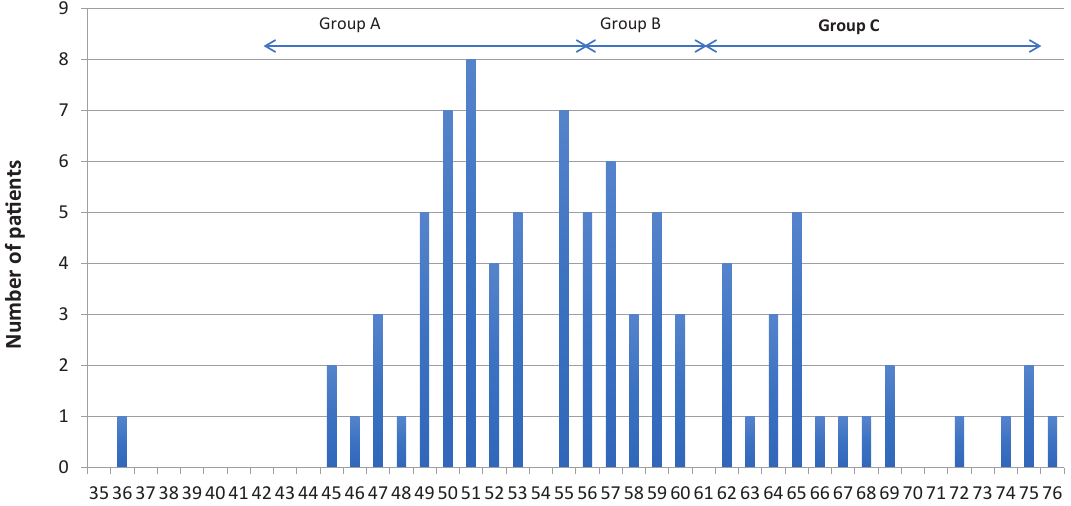
Figure 1. Age distribution of all patients. The participants were 89 female patients aged between 35 and 76 years (average 56.5 years) with hyperlipidemia whose serum free fatty acid concentrations were